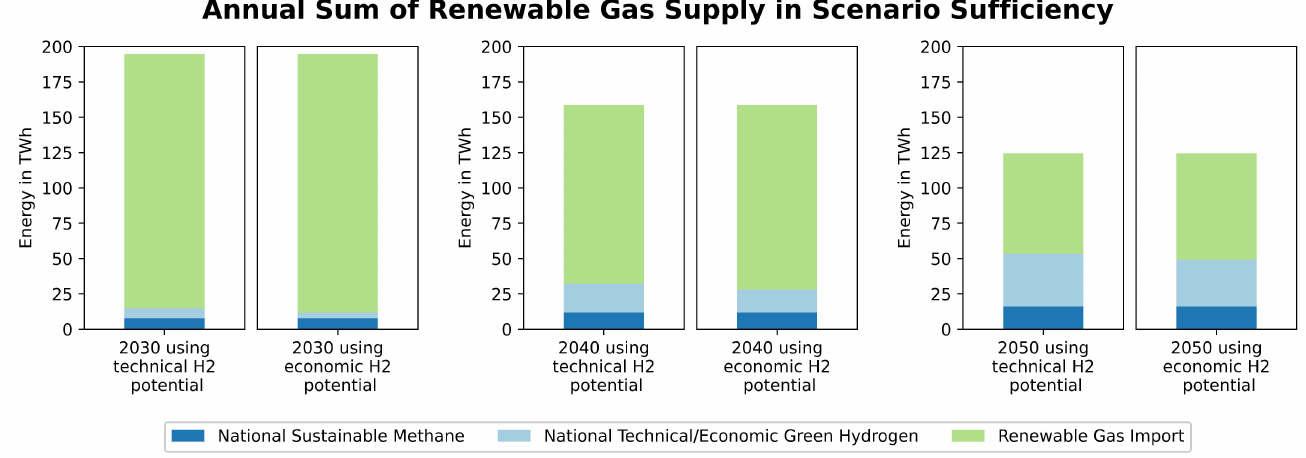
Figure 10. Comparison of renewable gas sources for the two cases: technical and economic green hydrogen potentials (only for the scenario Sufficiency